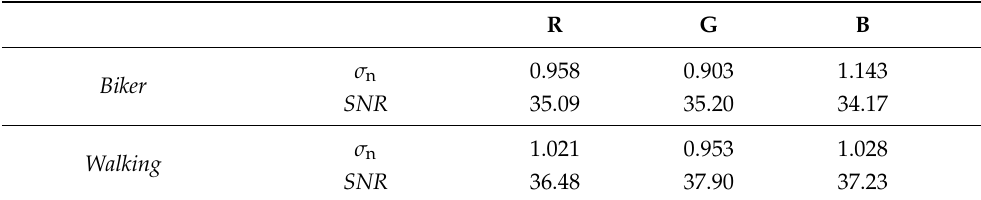
Table 3. Statistical characteristics of background